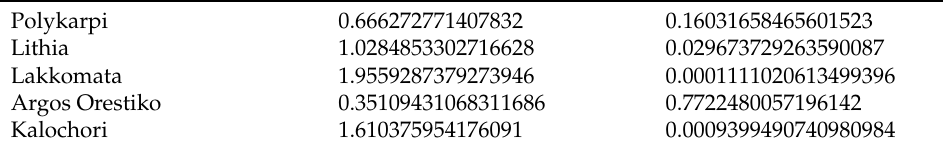
Table A3. p -values of Henze-Zirkler